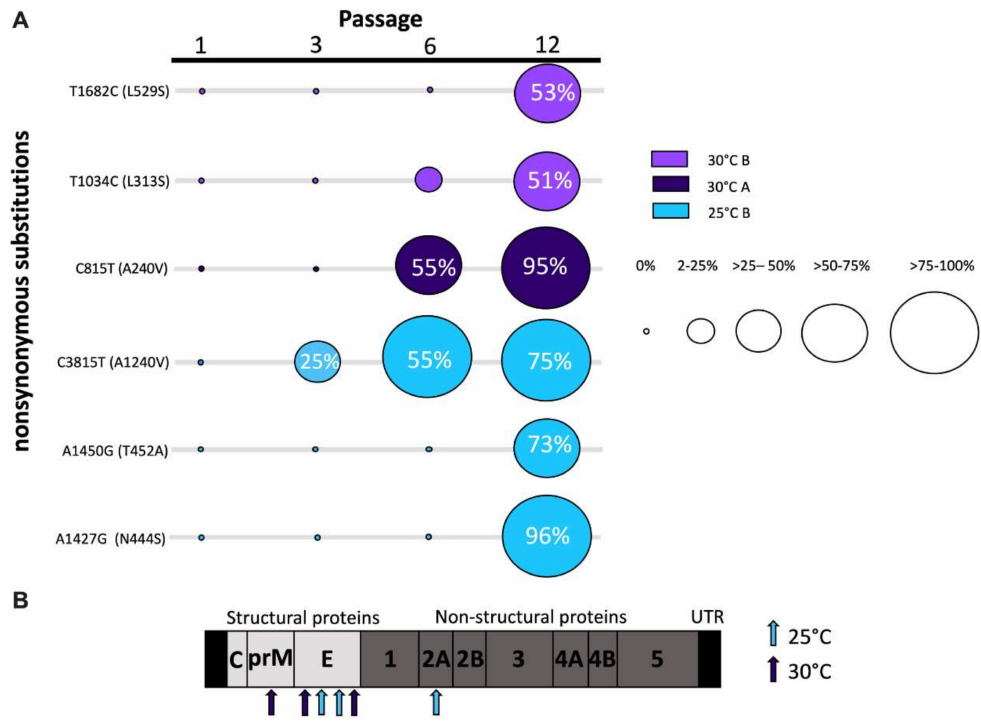
Figure 5. Nonsynonymous consensus mutations identified in West Nile virus following passage in mosquito cells. ( A ) Frequency of fixed nonsynonymous mutations identified throughout passaging. The proportion of sequences with mutation present is indicated by circle radius. Color indicates temperature and lineage. ( B ) Schematic of WNV genome and amino acid substitutions. Arrows indicate amino acid substitution location and color indicates passage temperature of associated